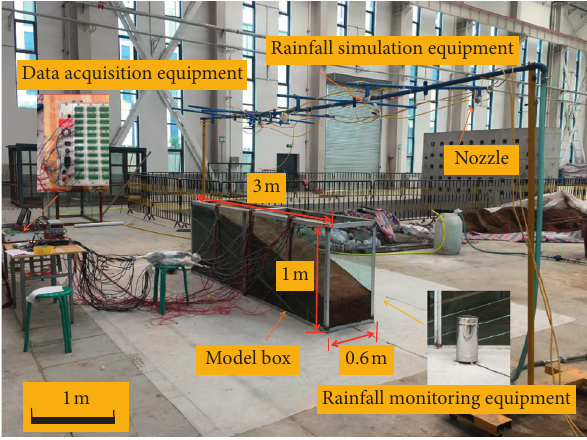
Figure 5: Rainfall equipment used in the Table 1: Model design similar parameters.